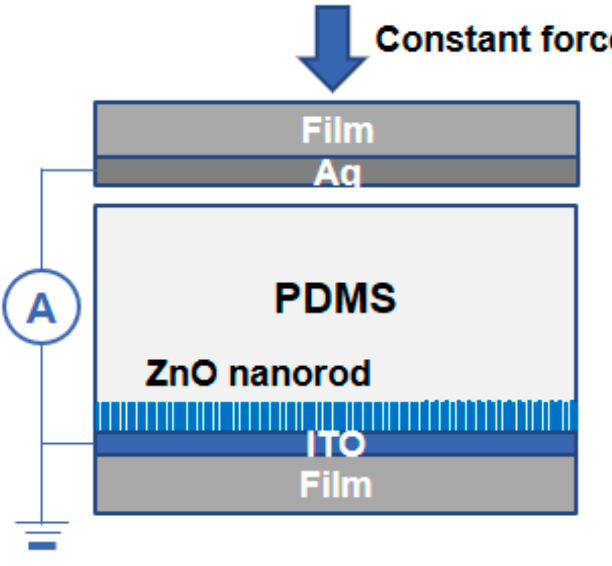
Figure 8. A schematic of test device fabrication of piezoelectric nanogenerators (NGs) for evaluation of power generation.